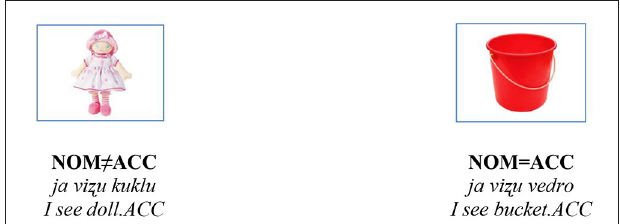
FIGURE 1 | Examples of items used in the ACC and the GEN production